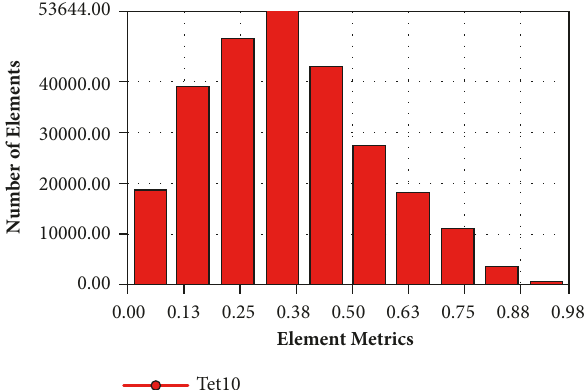
Figure 3: Evaluating the quality of the meshing.